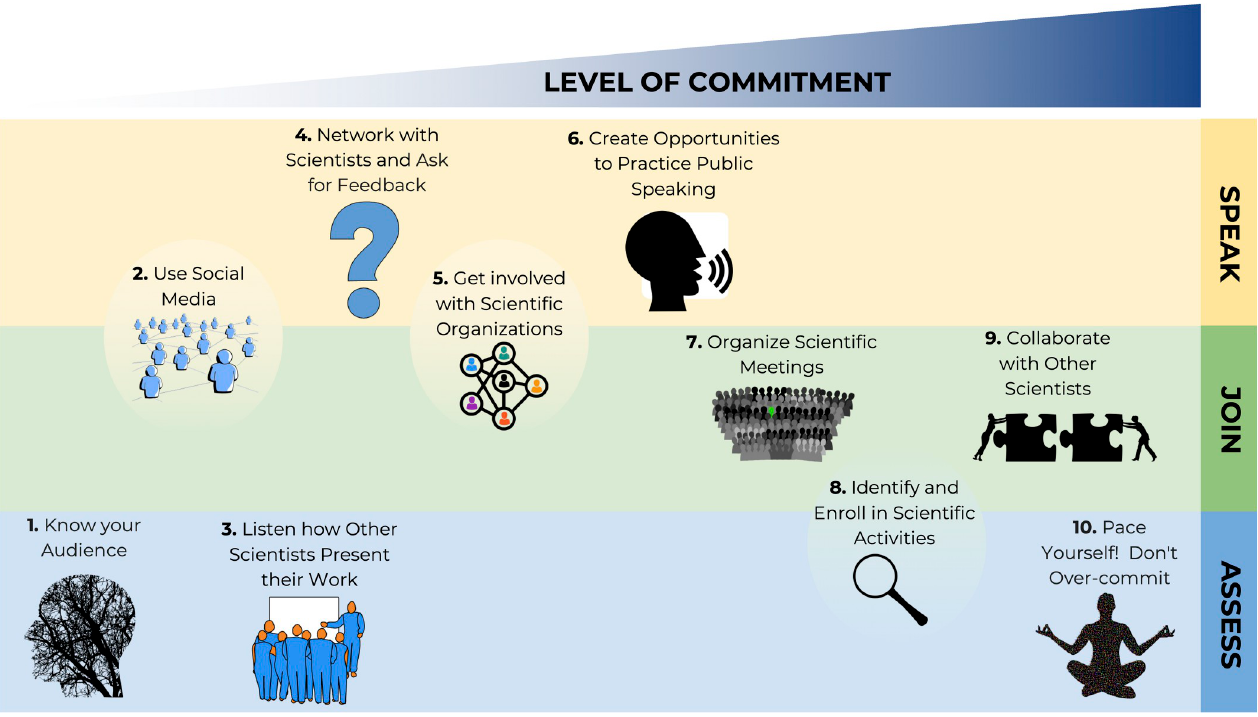
Fig 1. Outline of Ten simple rules for improving communication among scientists. These roles are organized based on the level of commitment required and grouped according to the categories: speak, join, and assess. The rules shown in circles form part of multiple categories. Figure created expressly for the article. Images contained within are from https://openclipart.org. Author credits are Rule 1: Gordon Dylan Johnson (@GDJ); Rule 2: Gordon Dylan Johnson (@GDJ); Rule 3: Bitterjug (@bitterjug); Rule 4: Priscilla (@barnheartowl); Rule 5: liftarn (@liftarn); Rule 6: amcolley (@amcolley); Rule 7: kattekrab (@kattekrab); Rule 8: Inkie 30 (@Inkie30); Rule 9: Gordon Dylan Johnson (GDJ); and Rule 10: Gordon Dylan Johnson (GDJ).